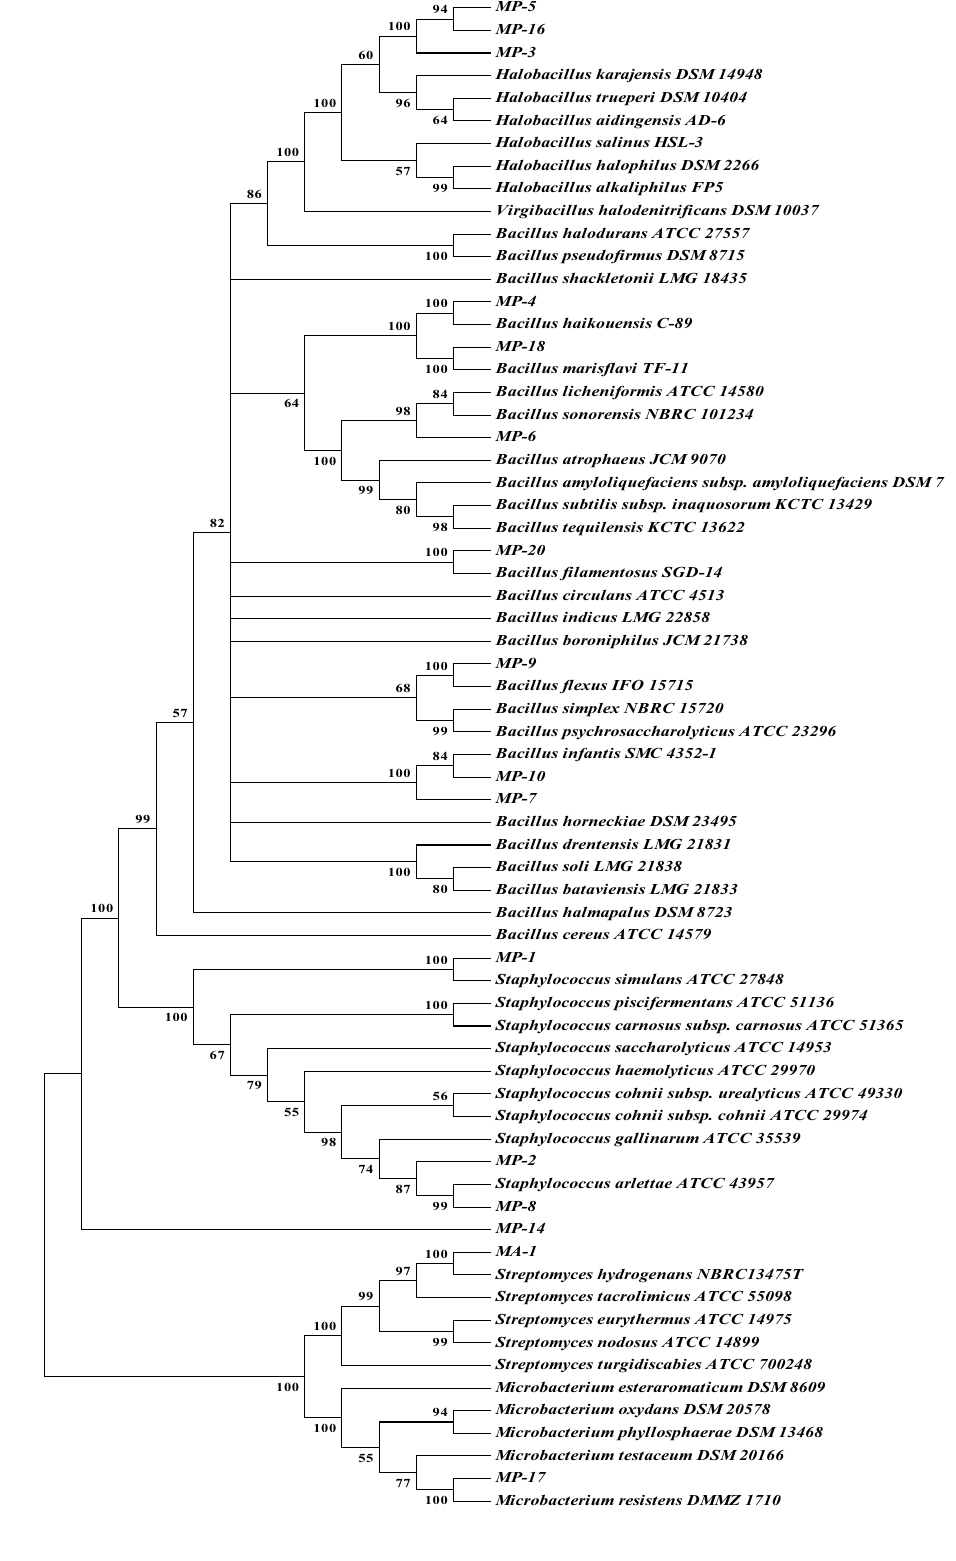
Fig. 1 Phylogenetic relationship between microbial consortium (Madhyam) culture isolates and representative species based on full-length 16S rDNA sequences constructed using the neighbor-joining